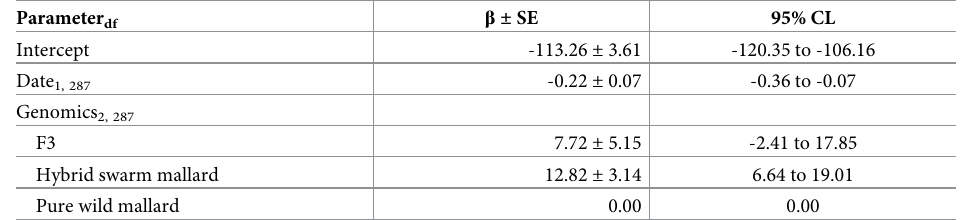
Table 1. Parameter estimates ± standard error (SE) and 95% confidence limits (CL) of factors affecting δ 2 H f of hatch-year mallards ( Anas platyrhynchos ) harvested in northwestern Ohio, 4 October–19 December